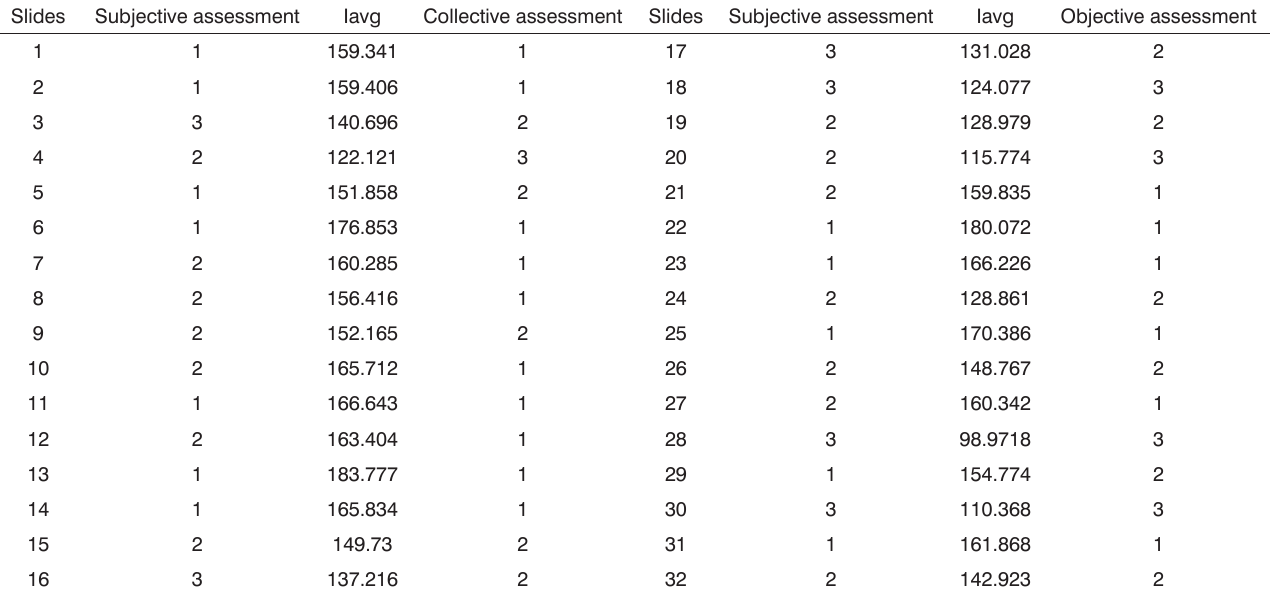
Table 1. Subjective evaluations, Iavg in pixels and objective assessments of the intensities of immunohistochemical reactions of the group of slides stained with